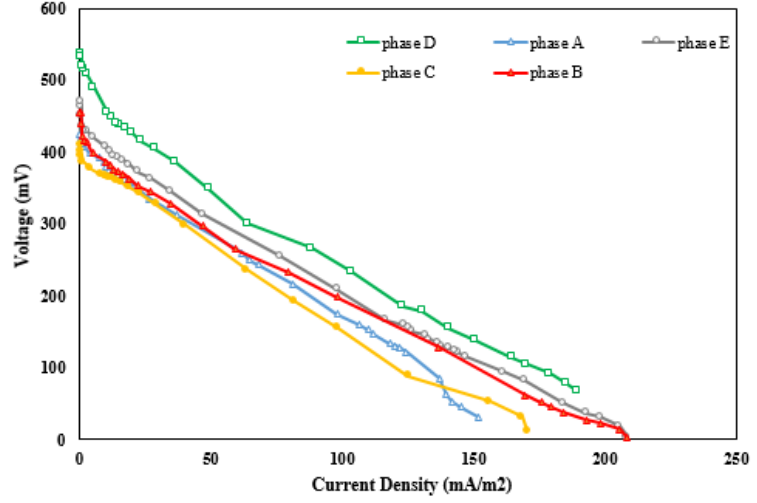
Figure 6. Polarization curves of all phases.